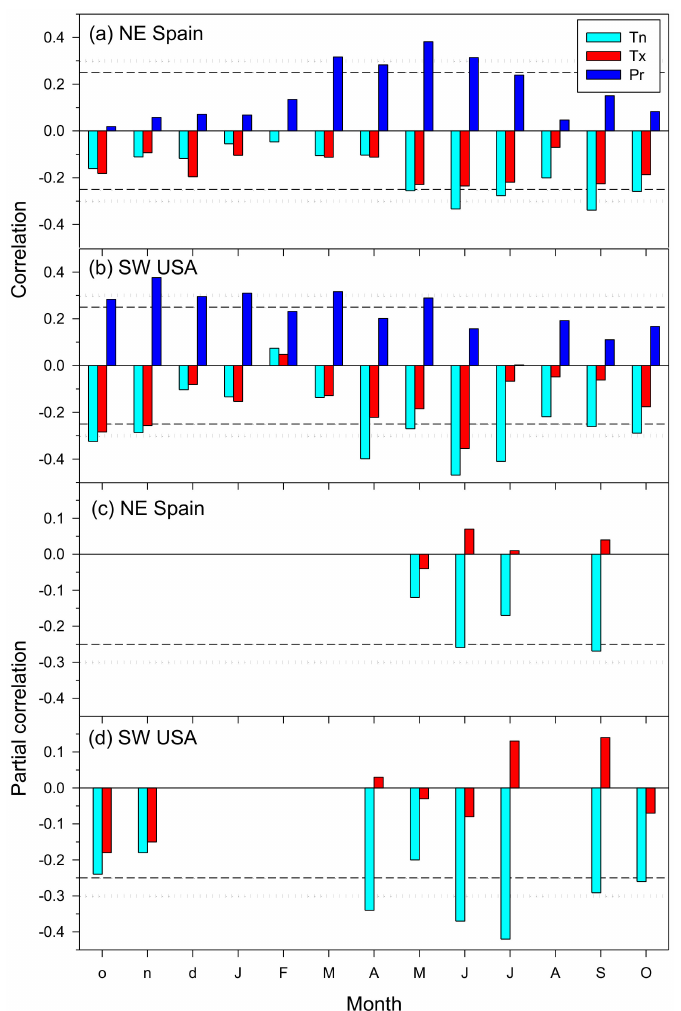
Figure 7. Climate–growth relationships assessed in two sites with different climate conditions but presenting latewood IADFs and potential growth bimodality: ( a , c ), Pinus halepensis in north-eastern Spain; ( b , d ), Pinus edulis in south-western USA. Plots ( a , b ) show Pearson correlations calculated between ring-width indices and climate variables (Tn, mean minimum temperature; Tx, mean maximum temperature; Pr, precipitation). Plots ( c , d ) show partial Pearson correlations by relating growth and minimum temperature after controlling for the influence of maximum temperature (blue bars) and vice versa (red bars). Partial correlations are only presented for months when minimum or maximum temperatures showed significant ( p < 0.05) correlations with ring-width indices (see plots ( a , b )). Months abbreviated by lowercase and uppercase letters correspond to the previous and current years, respectively. Horizontal dashed and dotted lines correspond to the 0.05 and 0.01 significance levels,